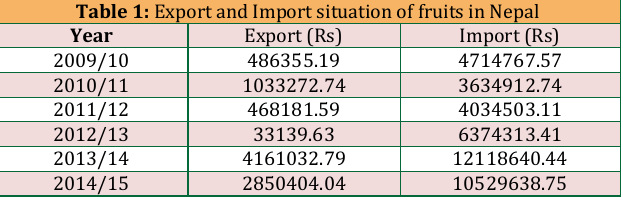
Table 2: Export and import situation of vegetables in Nepal Vegetables